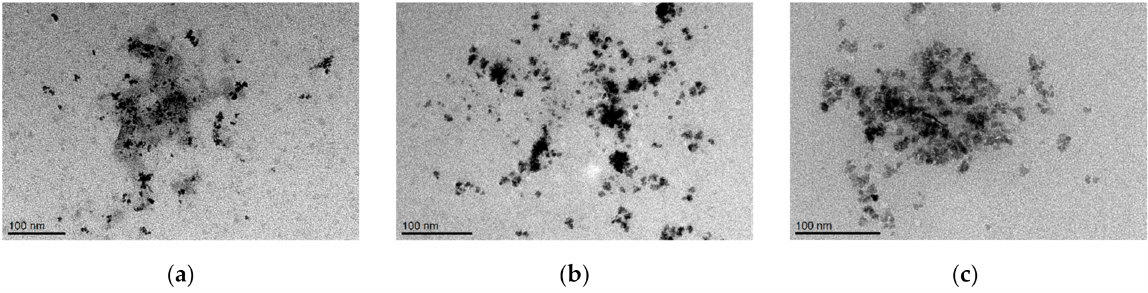
Figure 2. Cryogenic transmission electron microscopy images of magnetoferritin nanoparticles. Loading factor of magneto- ferritin: ( a ) 160; ( b ) 490; ( c ) 510.